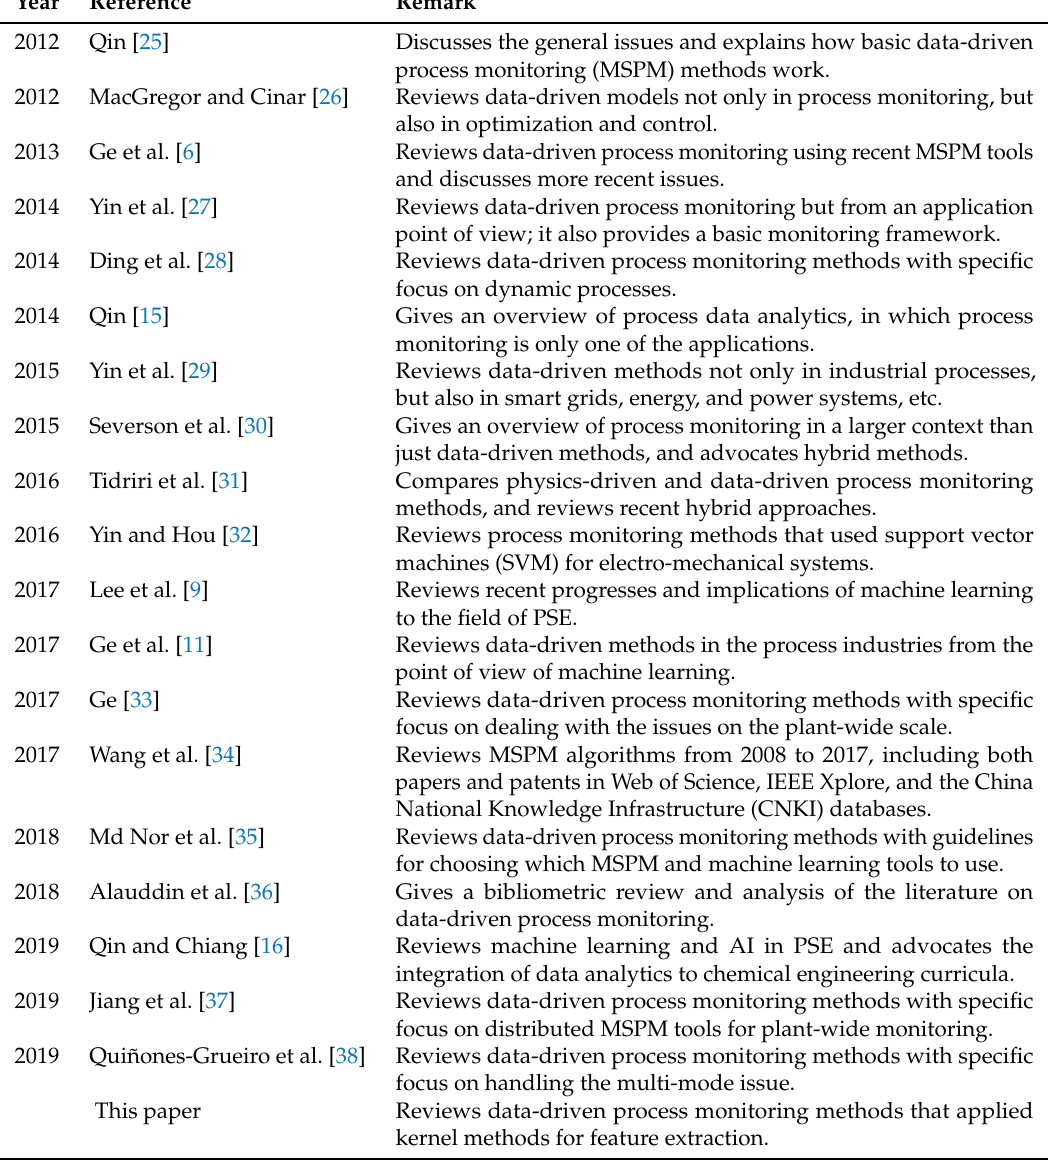
Table 1. Other recent reviews and their relationship to the present